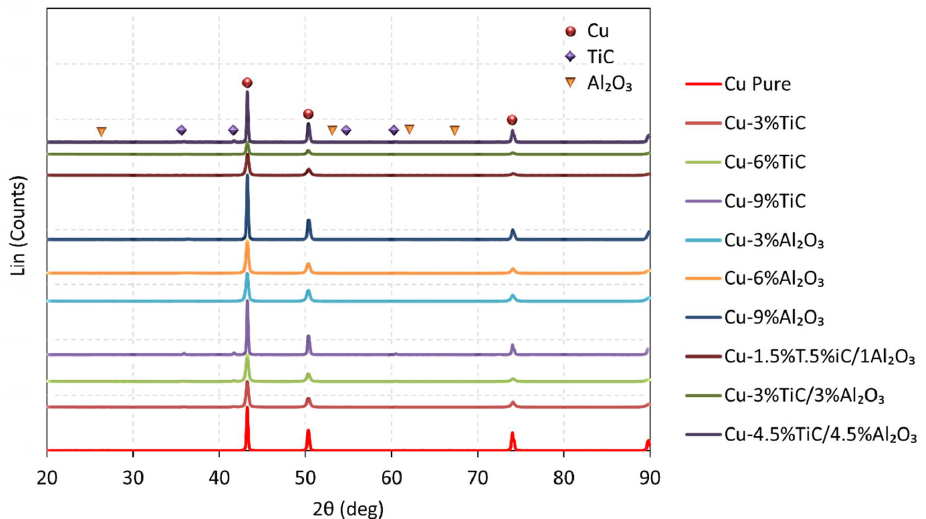
Figure 2. XRD patterns of composites after (SPS) process.